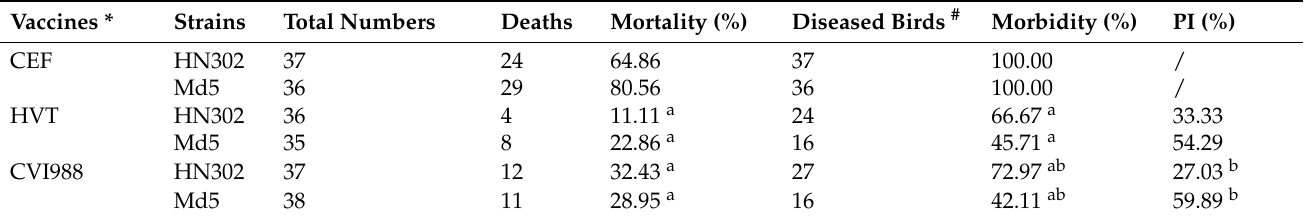
Table 3. Cumulative morbidity and mortality in vaccinated birds challenged by HNLC302 or Md5 strains calculated at 91 days post-challenge